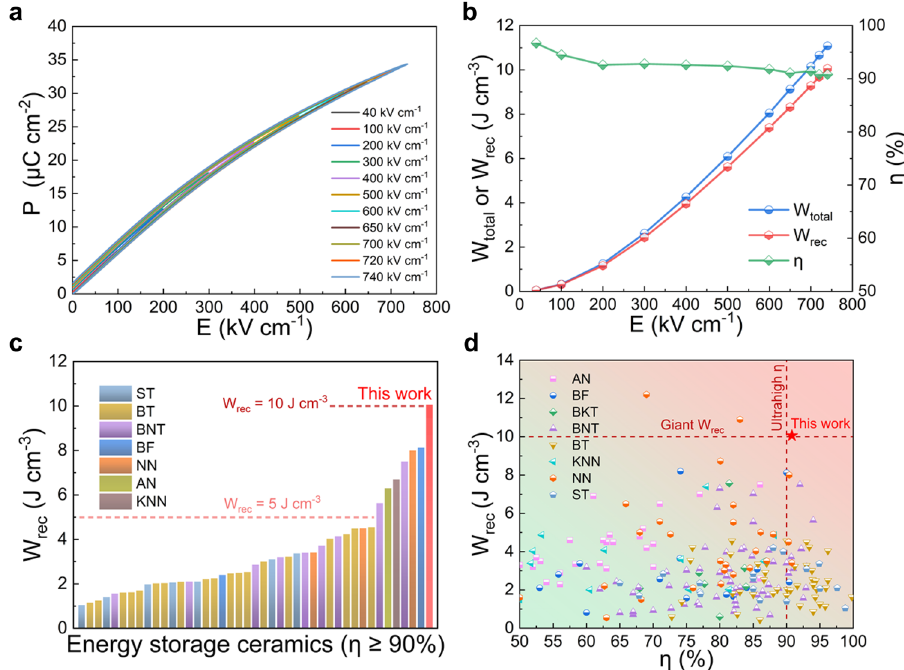
Fig. 4 Excellent energy storage performance of KNN-H ceramic. a P - E loops measured till the maximum applied electric fi elds of KNN-H ceramic. b W total , W η as a function of E for KNN-H ceramic. c Comparisons of W η ≥ 90%) between KNN-H ceramic and other reported lead-free bulk ceramics rec , and rec ( with W rec ≥ 1 J cm − 3 (ST: SrTiO 3 -based, BT: BaTiO 3 -based). d Comparisons of W rec versus η between KNN-H ceramic and other reported lead-free ceramics (BKT: Bi 0.5 K 0.5 TiO 3